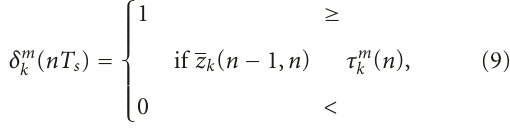
(cid:7) nT s m k ( t ; x 0 , ( n − 1) T s (cid:7) nT s ( n − 1, n ) = ( t ) dt . The Q ( · ) m 2 (cid:7) √ ( n − 1) T s k k ∞ 2 π e − t 2 / 2 dt x